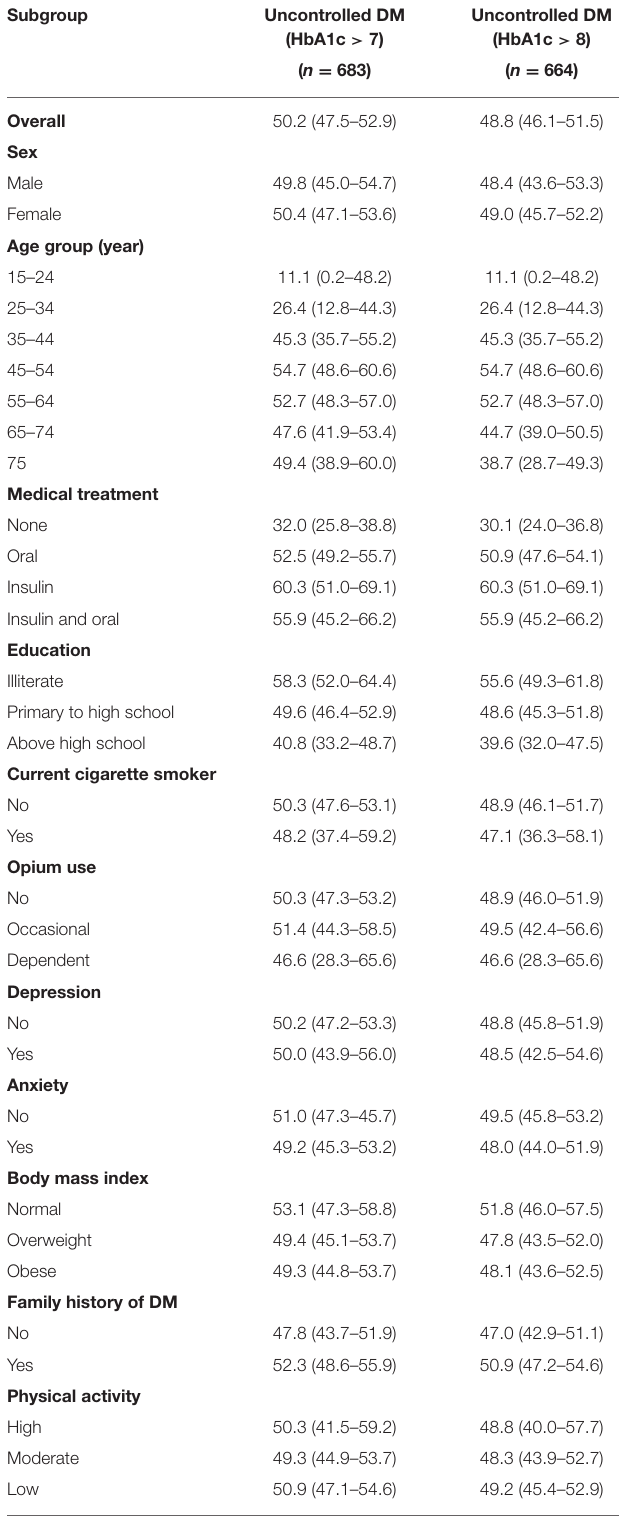
TABLE 2 | The prevalence % (CI) of un-controlled diabetes among diagnosed diabetes patients ( n = 1,359), community-based cohort study (KERCADRS 2nd Phase- N = 9,959), Kerman, Iran